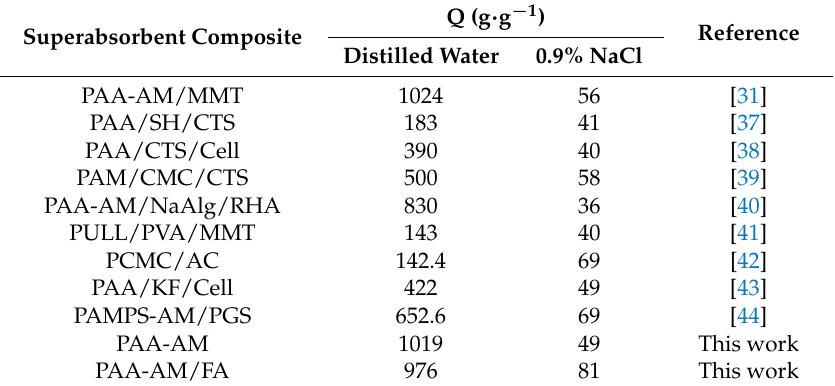
Table 5. The absorbency for water and salt-water of different superabsorbent composites.